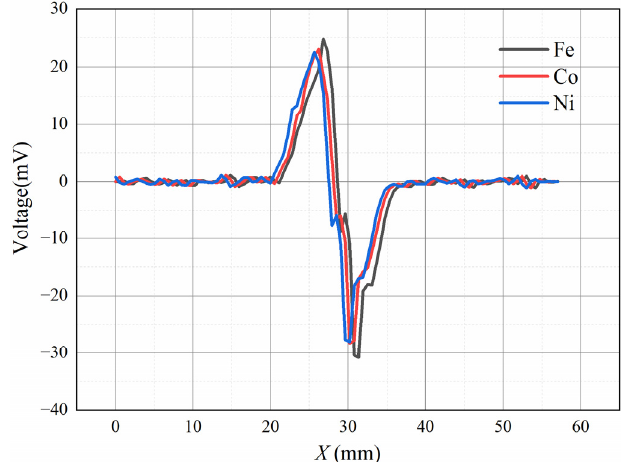
Figure 8. Influence of relative magnetic permeability.